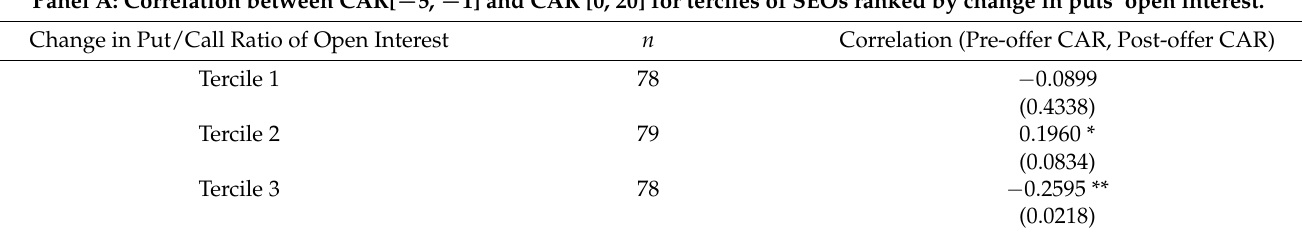
Panel B: Correlation between CAR[ − 5, − 1] and CAR [0, 20] for terciles of SEOs ranked by change in calls’ open interest. Change in Put/Call Ratio of Open